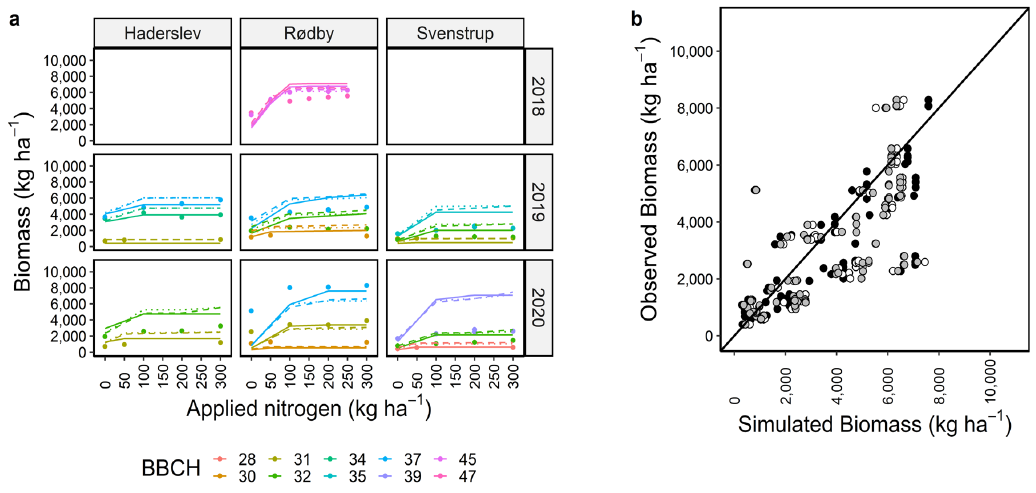
Figure 2. Calibration of the APSIM winter wheat biomass under 7–13 nitrogen management scenarios at different BBCH stages under three locations and years. Dots are observed data points and solid, dashed, and dotted lines are model outputs with the current calibrated set of parameters for Dan_winter, default, and modified cultivars, respectively ( a ). Black, white, and grey circles are for Dan_winter, default, and modified cultivars, respectively ( b ). Diagonal black line is 1:1 line ( b ). Discontinuous lines at 200 N application indicate the simulation outputs of single dose or split applications at the locations (Table S1). For Rødby, discontinuous line also indicated two simulations with different sowing dates.